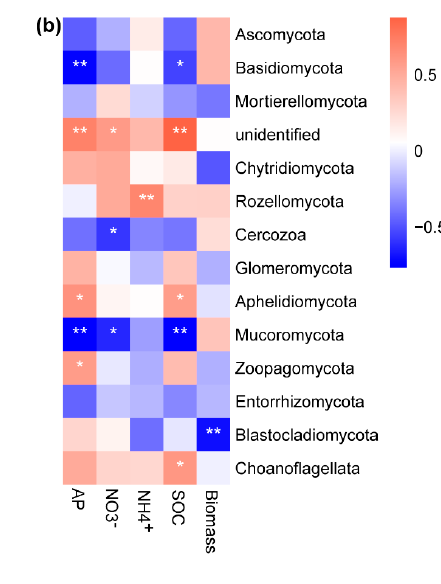
Figure 6. Partial least squares path modeling disentangling the direct and indirect pathways of the soil nutrients, fungal communities, and bacterial communities in Betula platyphylla biomass. Red and gray arrows indicate negative and positive effects, respectively. Asterisks represent significant ef- fects (*, p < 0.05; **, p < 0.01; ***, p < 0.001). Only significant pathways are shown. Numbers on the arrows indicate standardized path coefficients.